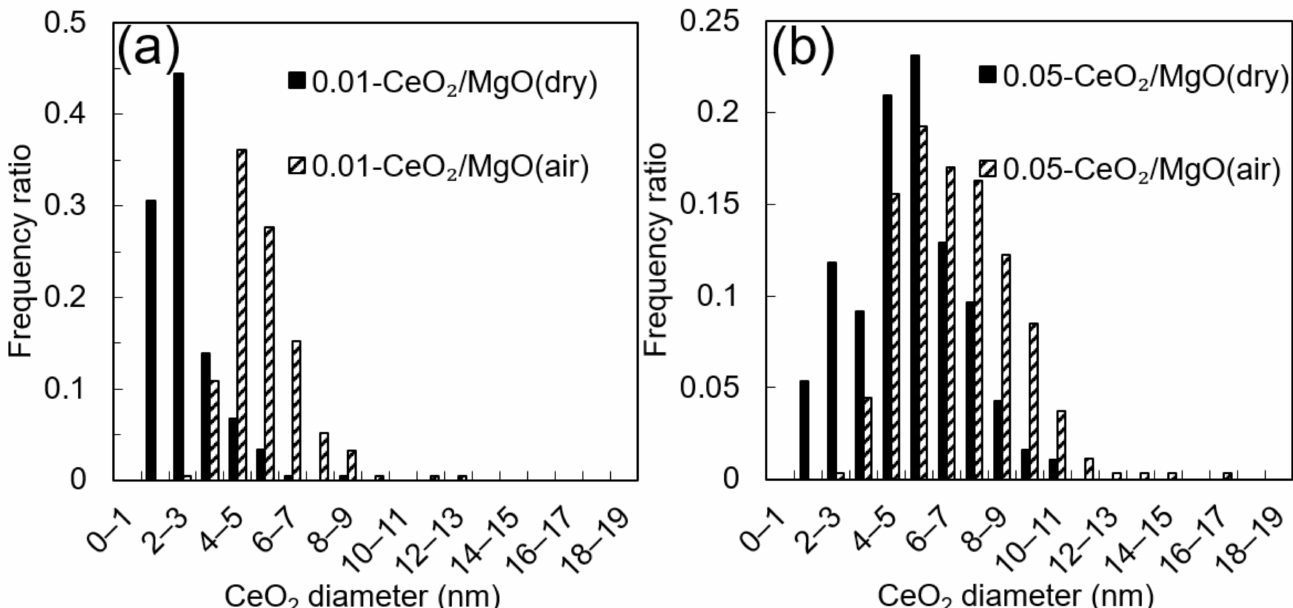
Figure 3. Frequency distribution of the CeO 2 diameter in ( a ) 0.01-CeO 2 /MgO, and ( b ) 0.05-CeO 2